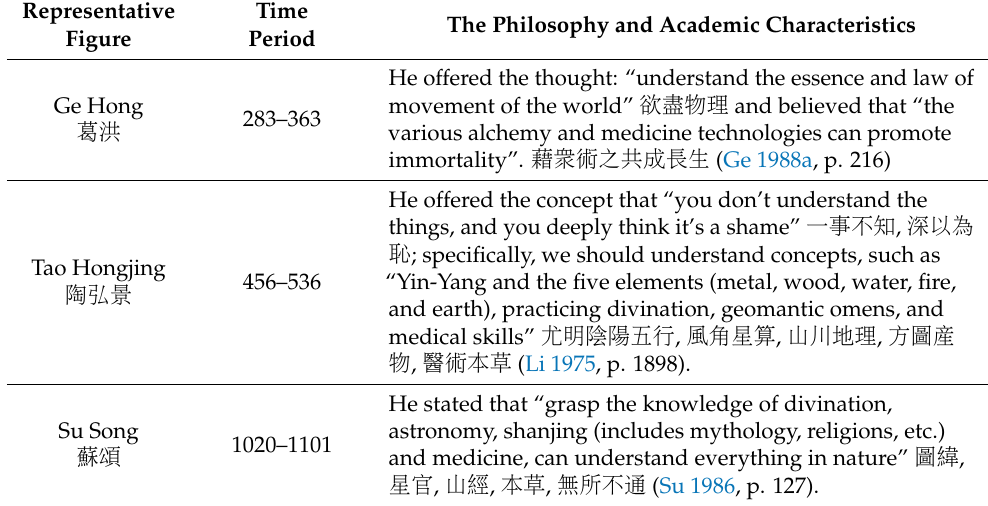
Table 1. The philosophical and academic characteristics of the representative figures in the Tao-Ge